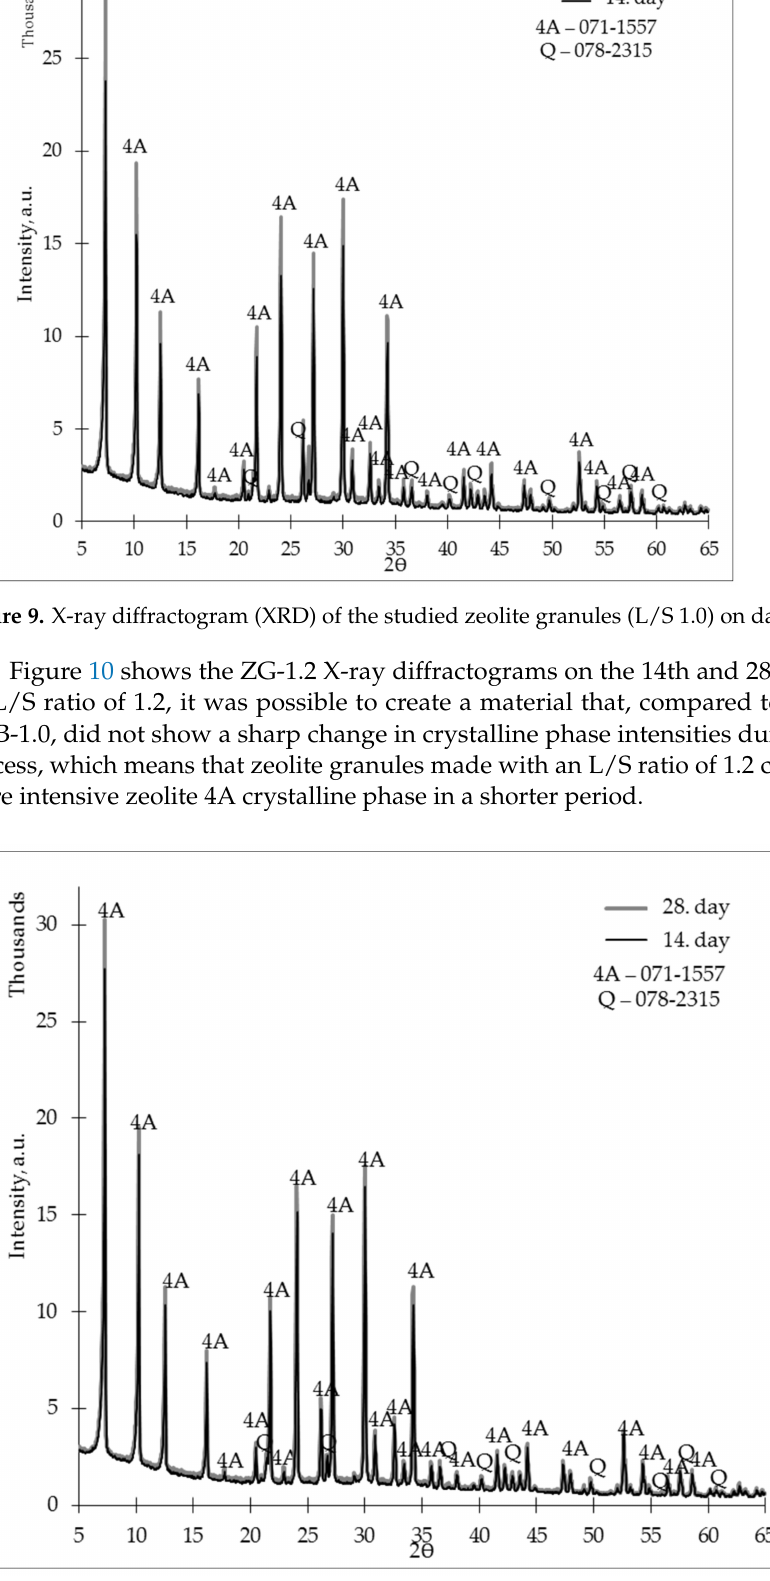
Figure 10. X-ray diffractogram (XRD) of the studied zeolites granules (L/S 1.2) on days 14 and